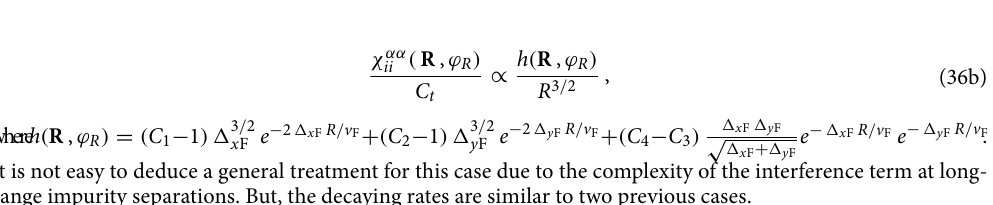
25 Å , ϕ R R = π/ { = 4 50 Å , ϕ R R = π/ } { =